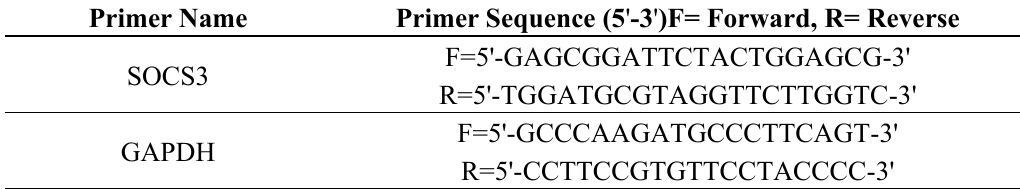
Table 1. Primers used in this